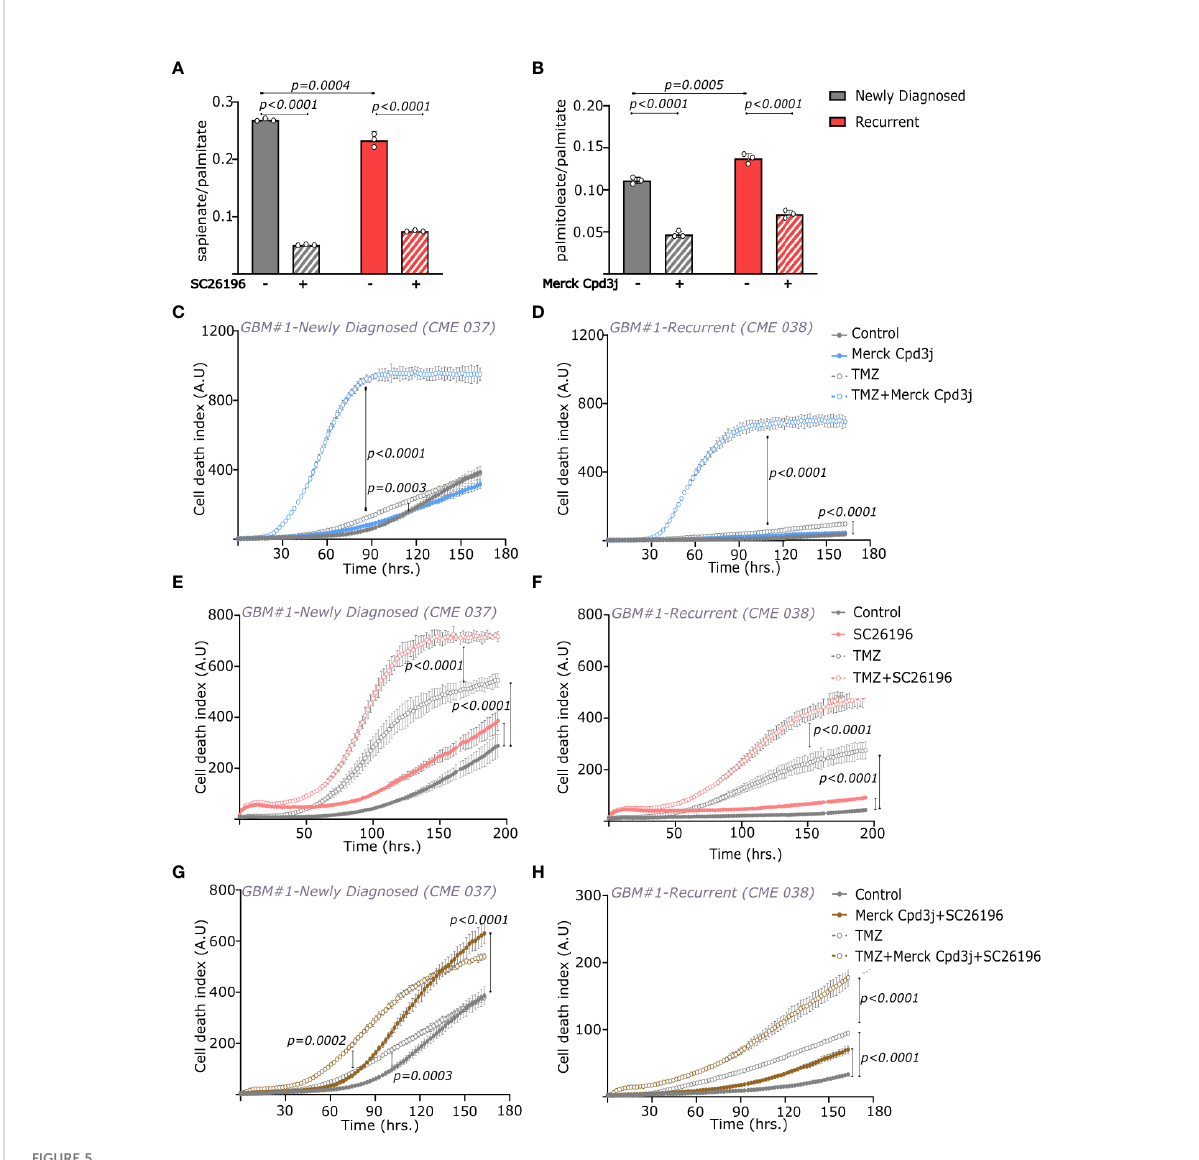
FIGURE 5 SCD and/or FADS2 inhibition in combination with temozolomide induces cell death in newly diagnosed and recurrent GBMs. (A) Sapienate and palmitate balance in newly diagnosed (CME 037) and recurrent (CME 038) cells from GBM#1 with and without FADS2 inhibitor, SC26196 (20 m M). Statistical analysis was performed using Two-way ANOVA with Tukey ’ s multiple comparison. n=3. (B) Palmitoleate and palmitate balance in newly diagnosed (CME 037) and recurrent (CME 038) cells from GBM#1 with and without SCD inhibitor, Merck Cpd3j (1nM). Statistical analysis was performed using Two-way ANOVA with Tukey ’ s multiple comparison. n = 3. (C, D) Cell death index (number of dead cells/con fl uence) over time in (C) newly diagnosed (CME 037) and (D) recurrent (CME 038) cells from GBM#1 ± TMZ (250 m M) and ± SCD inhibitor, Merck Cpd3j (2nM). Statistical analysis was performed using Two-way ANOVA with repeated measures and Sidak ’ s multiple comparison. n = 5. (E, F) Cell death index (number of dead cells/con fl uence) over time in (E) newly diagnosed (CME 037) and (F) recurrent (CME 038) cells from GBM#1 ± TMZ (250 m M) and ± FADS2 inhibitor, SC26196 (20 m M). Statistical analysis was performed using Two-way ANOVA with repeated measures and Sidak ’ s multiple comparison. n = 5. (G, H) Cell death index (number of dead cells/con fl uence) over time in (G) newly diagnosed (CME 037) and (H)